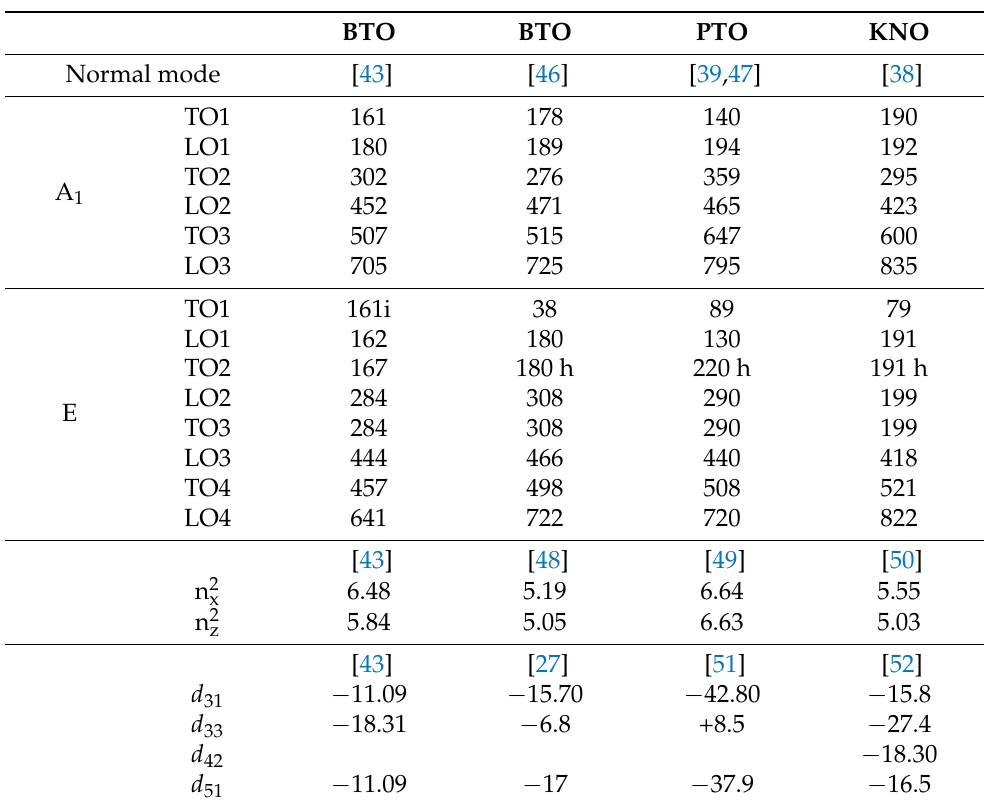
Table 2. Raman frequencies (cm − 1 ) of BTO, PTO, and KNO; the corresponding refractive indices; and the d-NLO coefficients (pm/V), respectively. Some d-NLO coefficients of the KNO material [44,45] can also be considered for EO calculations if